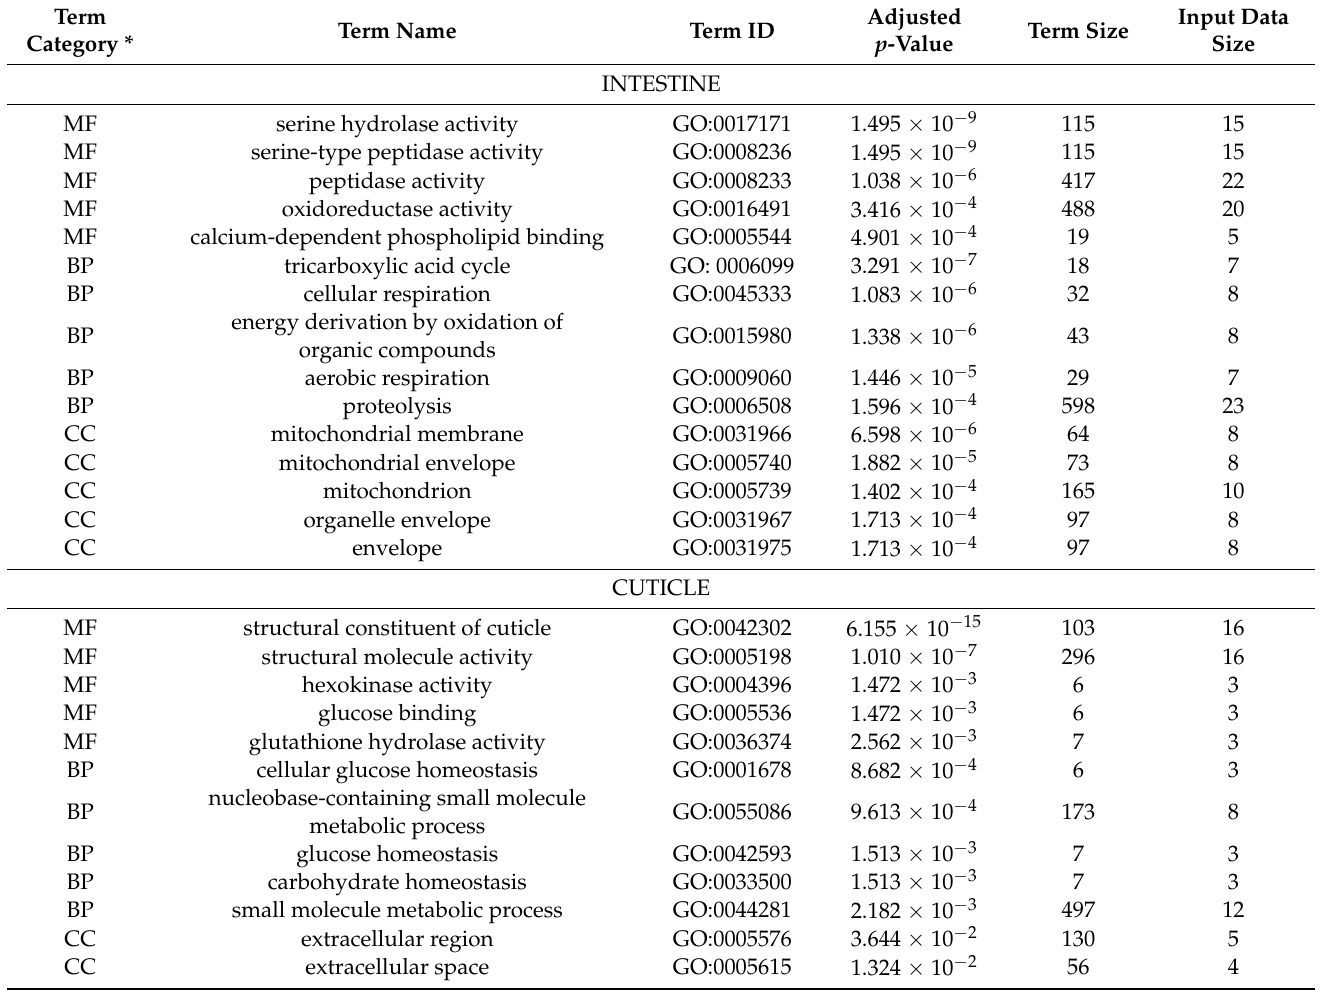
Table 1. The top subcategories from each GO category obtained in g:Profiler. The adjusted enrichment p -values with the number of proteins assigned to each subcategory are presented. For graphical representation, see Figure 4. Detailed annotation of all proteins submitted to the analysis can be found in Files S1 and